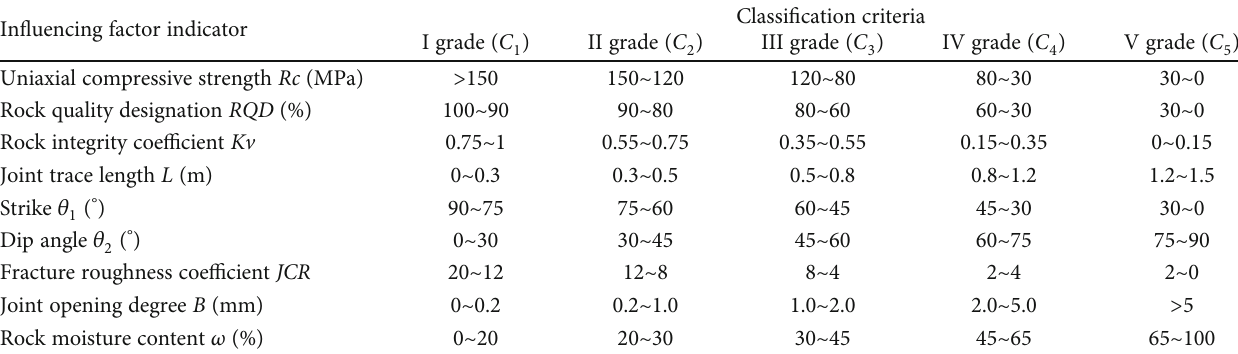
Table 1: Structural plane evaluation classi fi cation standard.